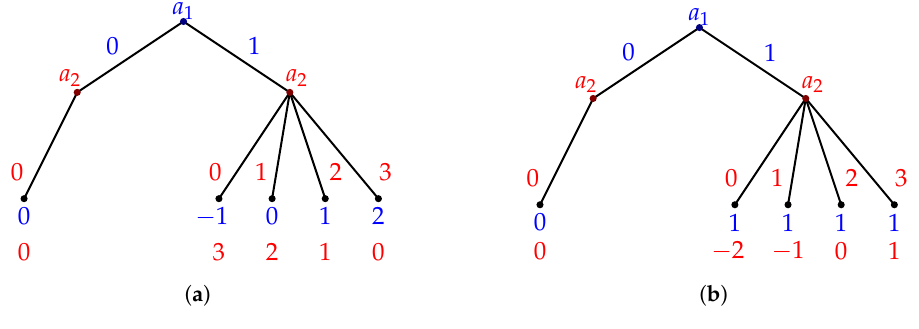
Figure 5. Trust Game ( a ); and Conscience Game ( b